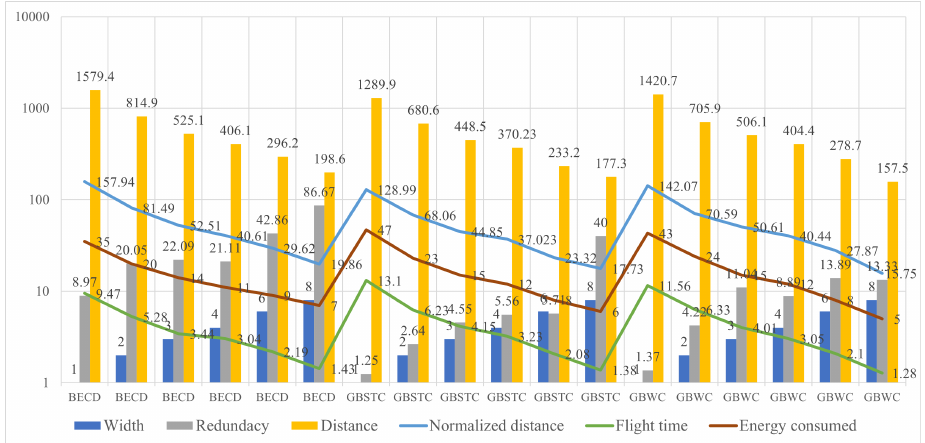
Figure 15. Performance metrics of 3DR Iris UAV on CSUSL PV plants (Experiment